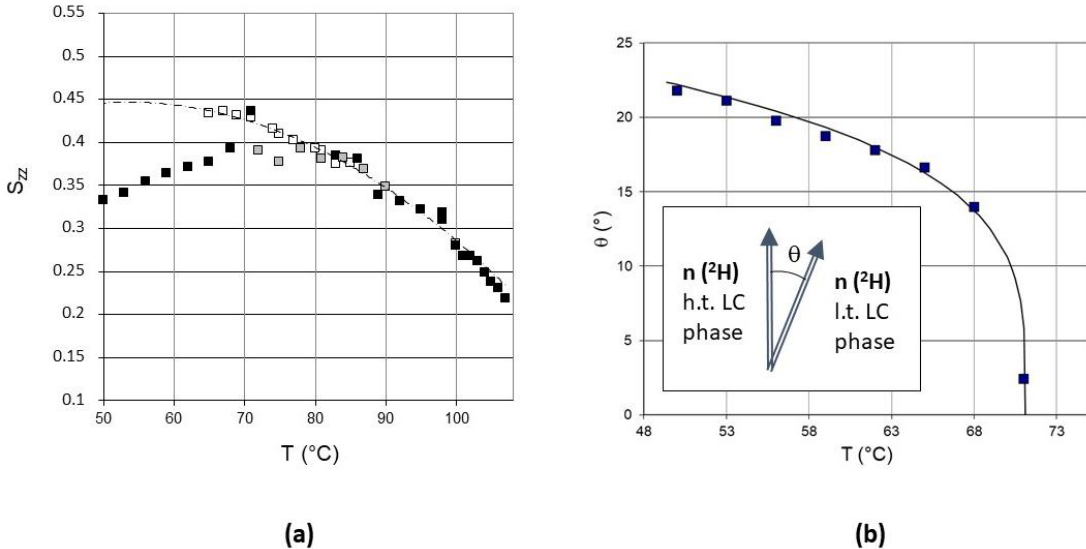
Figure 5. ( a ) Trend of the orientational order parameter S zz , referring to the biphenyl para axes, as a function of temperature (T/ °C), determined by analyzing the 2 H NMR spectra. The empty squares refer to data obtained from 1 H-decoupled 2 H NMR spectra, black full squares and grey full squares to data obtained from 2 H NMR spectra acquired without 1 H decoupling, on cooling and on heating the sample, respectively. The dashed curve corresponds to the extrapolation from the high temperature aligned phase to low temperature tilted phase. ( b ) Trend of the average tilt angle, θ , in the low temperature titled phase. The black curve corresponds to the best fitting curve by using Equation (3), as described in the text. In the inset, the angle θ is defined showing the relative orientation of the average director, as detected by 2 H NMR in the low temperature (l.t.) and high temperature (h.t.) LC phases.